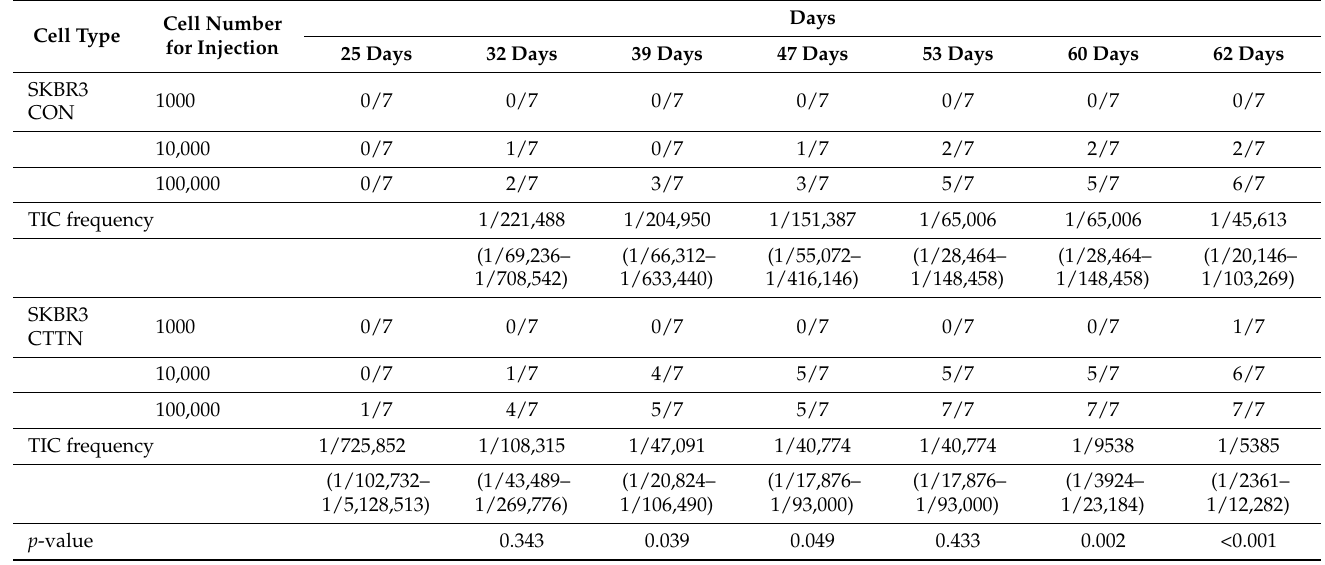
Table 1. CTTN enhances tumor-initiating ability in NOD/SCID